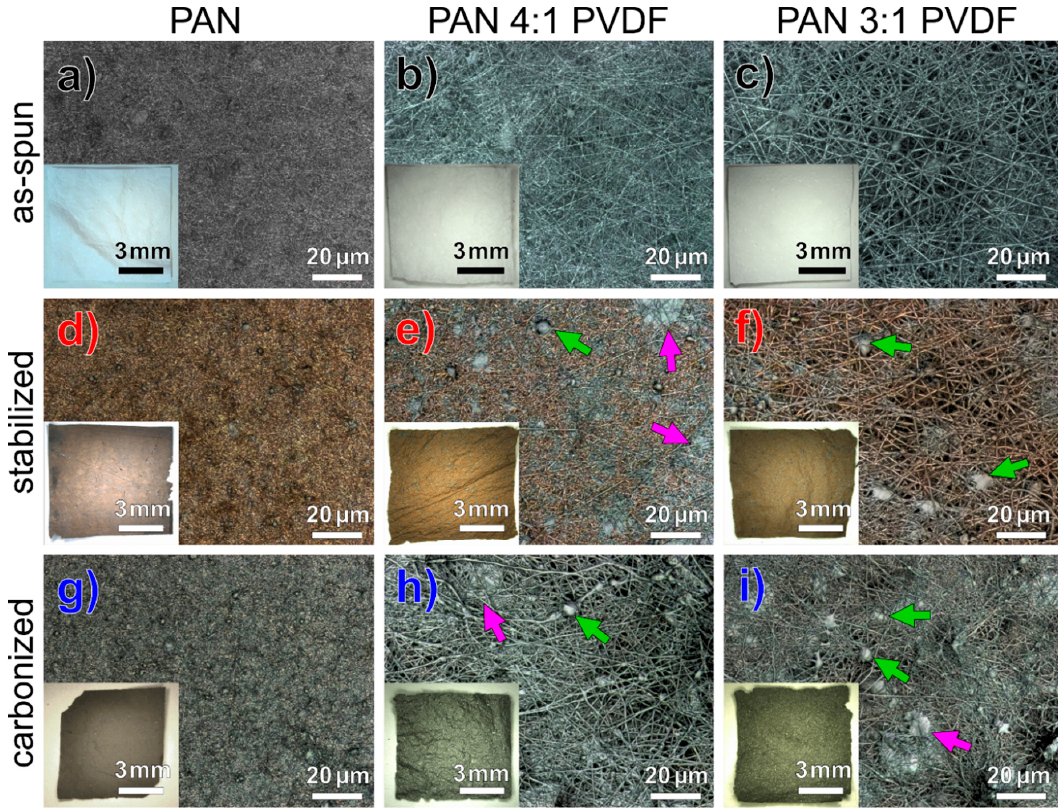
Figure 1. CLSM images and inserted photographs of ( a – c ) as-spun, ( d – f ) stabilized and ( g – i ) carbonized nanofiber nonwovens. Arrows indicate agglomerates (green) and membranous areas (purple).